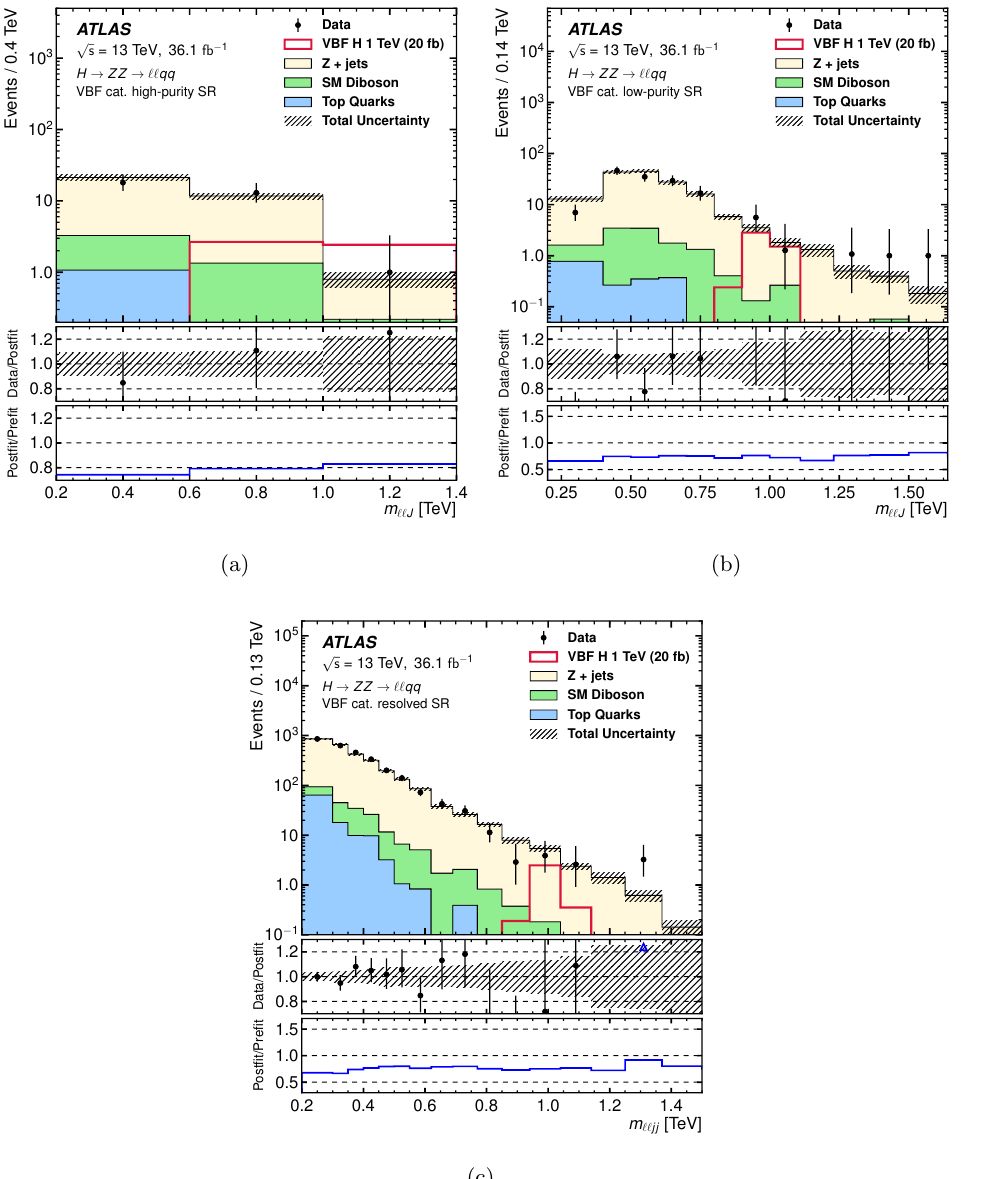
Figure 7 . Comparisons of the observed data and expected background distributions of the (cid:12)nal discriminants of the VBF category for the H and (b) low-purity signal regions; (c) m ‘‘jj of the resolved signal region. For illustration, expected distributions from the VBF production of a 1 TeV Higgs boson with (cid:27) shown. The middle panes show the ratios of the observed data to the background predictions. The uncertainty in the total background prediction, shown as bands, combines statistical and systematic contributions. The blue triangles in the middle panes indicate bins where the ratio is nonzero and outside the vertical range of the plot. The bottom panes show the ratios of the post-(cid:12)t and pre-(cid:12)t background predictions.